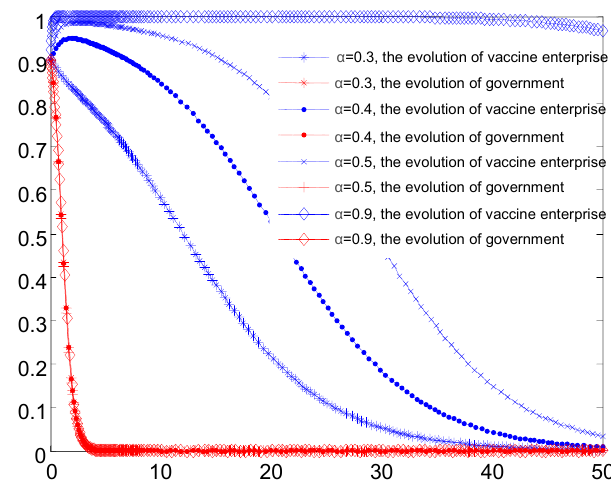
Figure 4. Simulation results of the evolutionary game between the two parties under the condition that the success rate of government’s active supervision is increased.